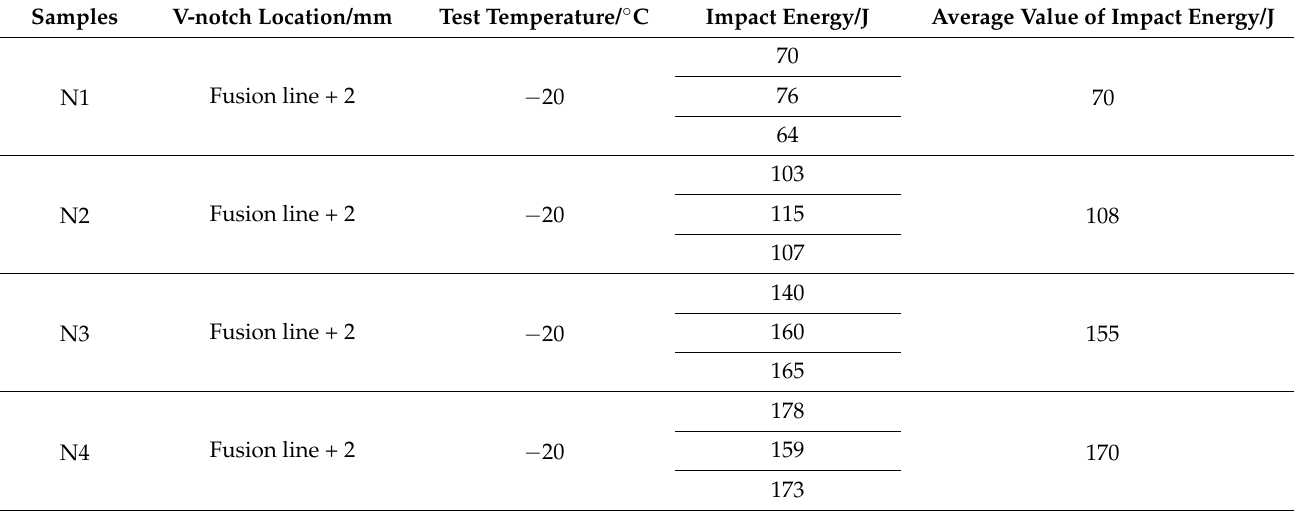
Table 3. The impact test scheme and impact energy of the heat-affected zone (HAZ) in steel. Samples V-notch